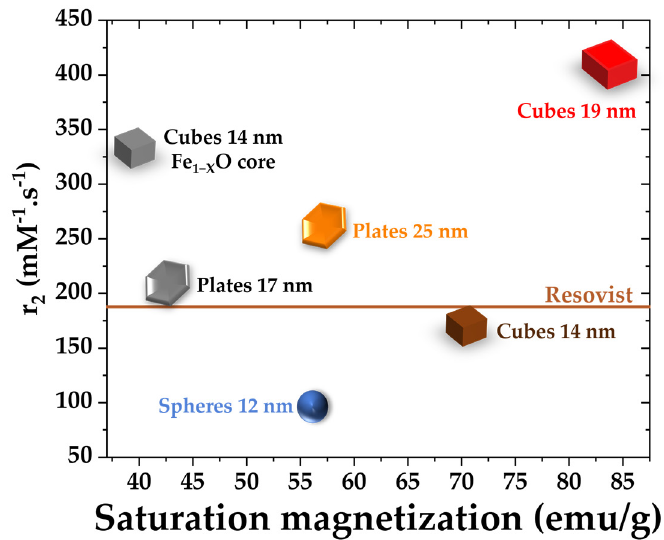
Figure 5. Relaxivity value r 2 as a function of the saturation magnetization of the various batches.